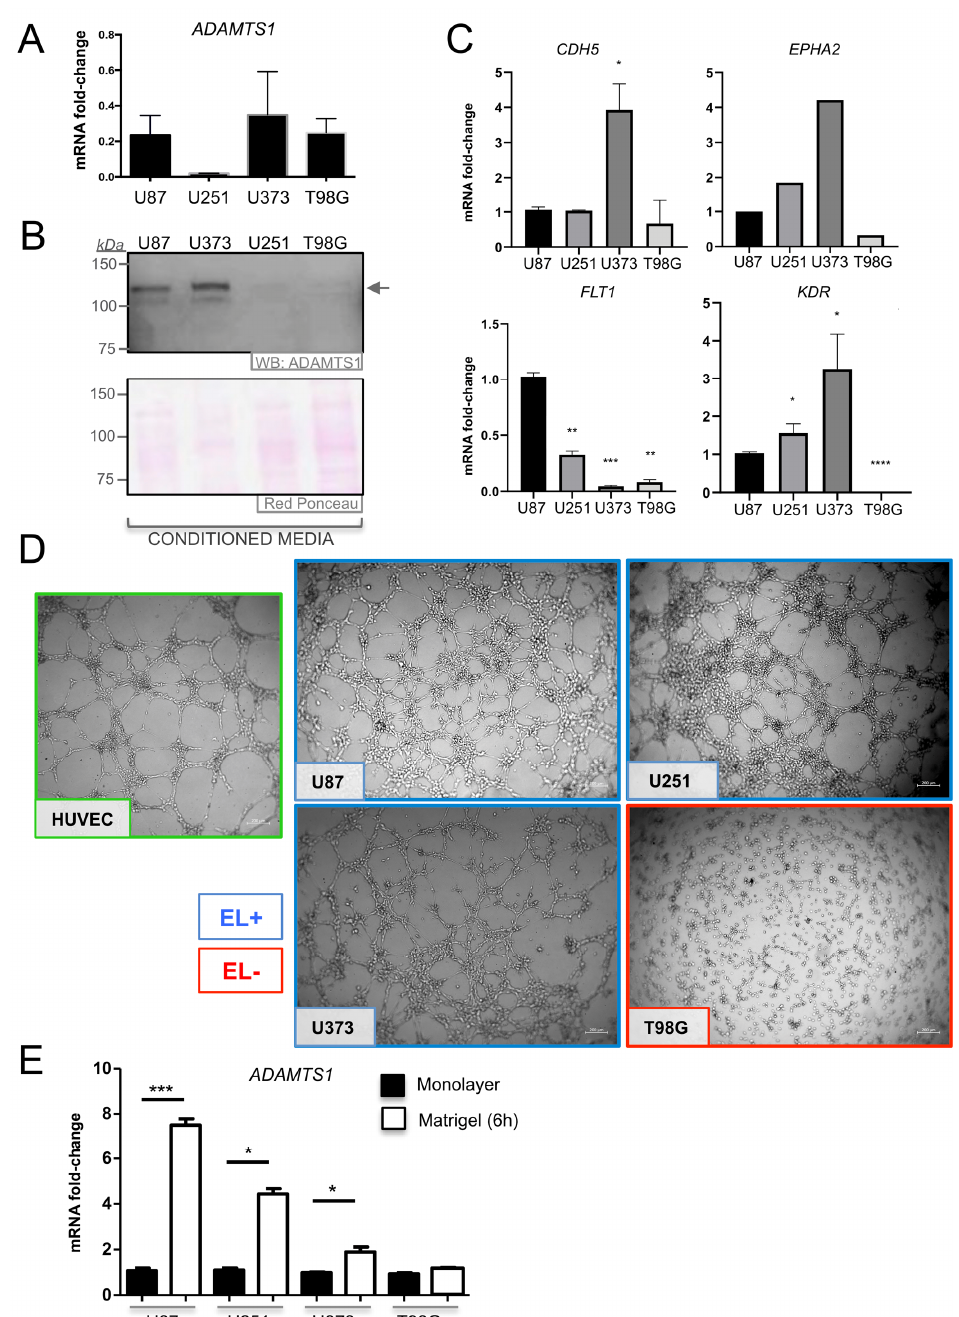
Figure 4. Analysis of ADAMTS1 in GBM cells and evaluation of their endothelial-like properties. ( A ) Graph representing mRNA fold change expression of ADAMTS1 in GBM cells: U87-MG, U251-MG, U373-MG and T98G (values are relative to U87-MG cell line) ( n ≥ 6 for all cell lines); ( B ) western blot analysis of ADAMTS1 in conditioned media of GBM cells. Black arrow points to full-length (FL) ADAMTS1. Red Ponceau staining was used as loading control; ( C ) graphs representing mRNA fold change expression of CDH5 , EPHA2 , FLT1 and KDR in GBM cells (values are relative to U87-MG cell line) ( n ≥ 3 for all genes except EPHA2 , n = 1); ( D ) representative images of 3D Matrigel-based assay of HUVEC (green square) and GBM cells, 24 h after seeding (white scale bar = 200 µ m); EL+ (blue square) and EL − (red square) cells are indicated; ( E ) graph representing mRNA fold change expression of ADAMTS1 in GBM cells as monolayer (black bar) or in Matrigel assay (white bar) ( n ≥ 4 for all conditions). (****, p < 0.0001; ***, p < 0.001; **, p < 0.01, and *, p <